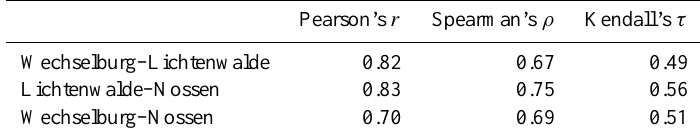
Table 1. Bivariate correlation coefficient of the coinciding peak values at the gauging stations Wechselburg, Lichtenwalde and Nossen.